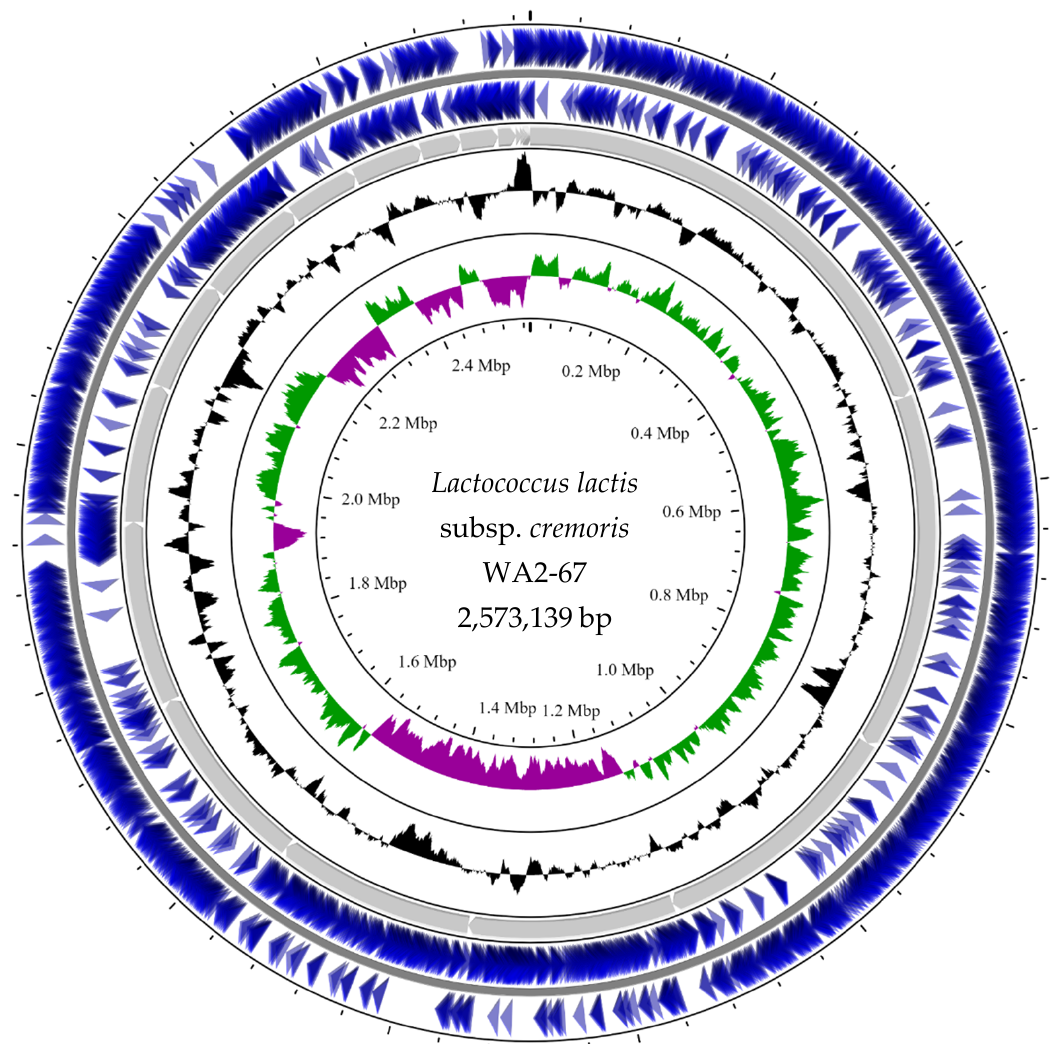
Figure 1. L. cremoris WA2-67 genome map generated using the CGView Server (http://cgview.ca/, accessed on 25 December 2021) [25], showing a full view of the genome. The blue arrows represent the CDSs and the gray arrows the contigs. The black plot shows GC content, while the green and magenta plot shows CG skew + and − , respectively.